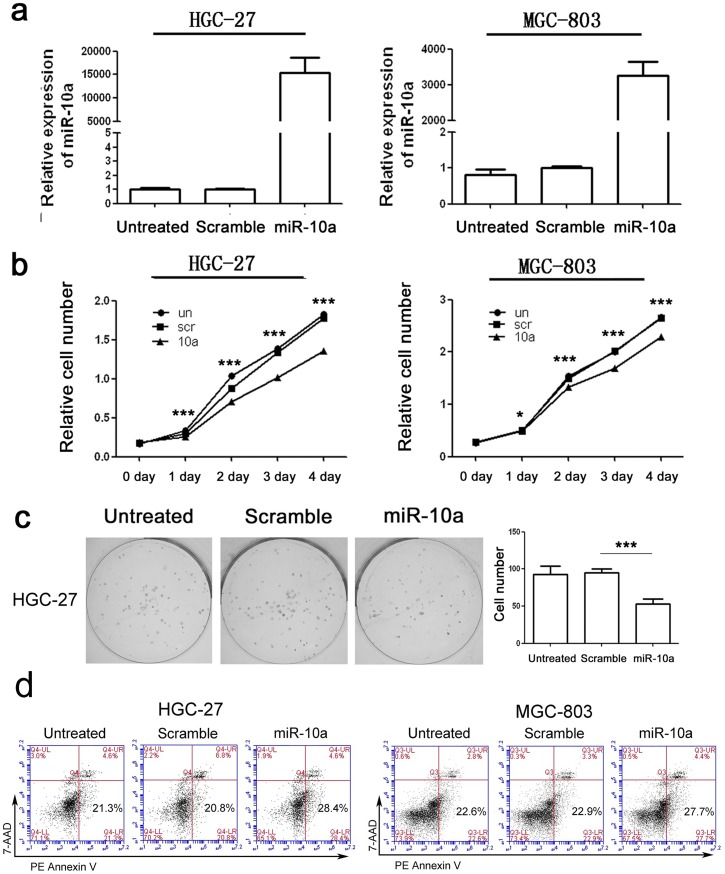
miR-10a inhibits cell proliferation in vitro.
a miR-10a expression in HGC-27 and MGC-803 cells transfected with 50 nmol/L scramble or miR-10a mimic for 48 h. b Growth assays by cck-8 at 0, 1, 2, 3, 4 days after mimic transfection. c Colony formation assay of untreated, scramble-transfected, and miR-10a-transfected HGC-27 cells. d MGC-803 and HGC-27 cells were stained with PE Annexin V and 7-AAD 72 h after treatment with miR-10a mimics or scramble. Early apoptotic cells are shown in the bottom right quadrant. All data are presented as the means ± SD. *, P<0.05; **, P<0.01, ***, P<0.001.